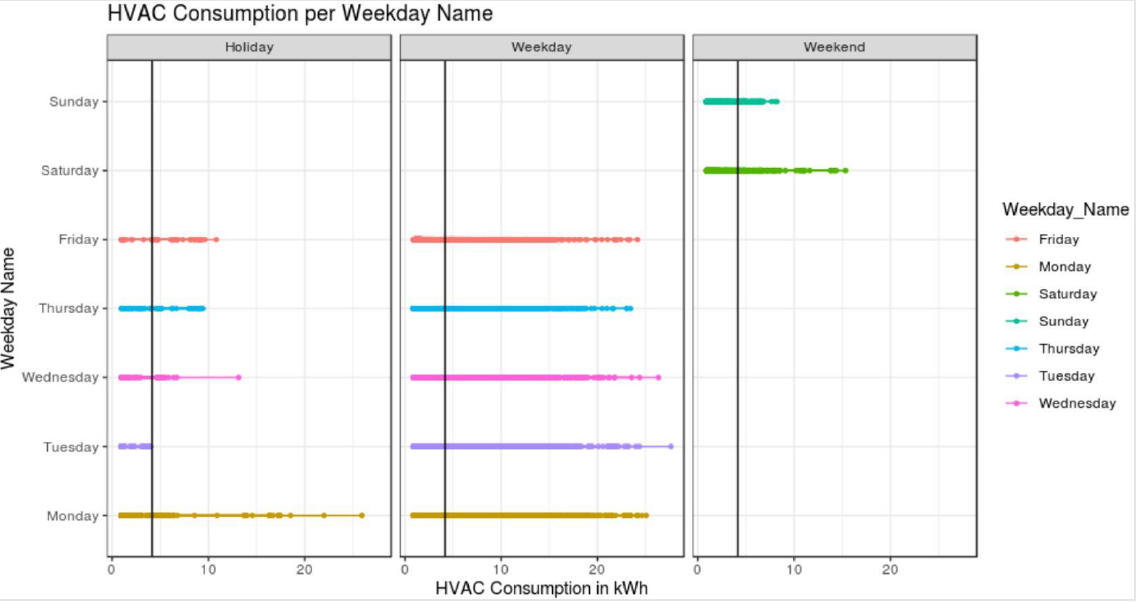
Figure 6. HVAC consumption per weekday name.